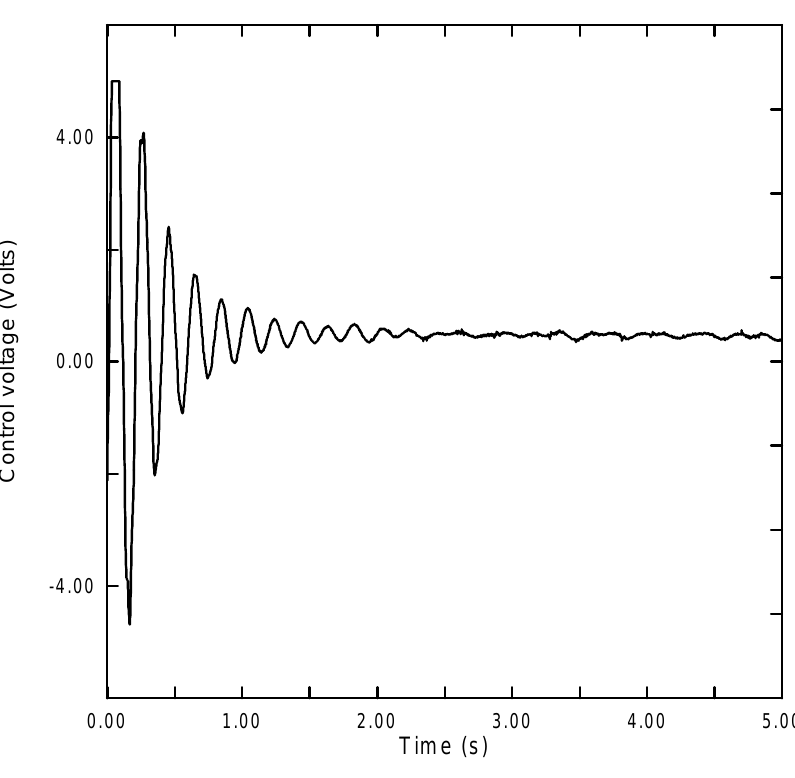
Fig. 15. Closed-loop control voltage response of the